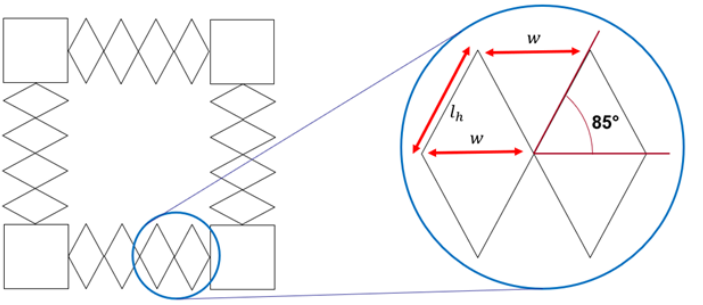
Figure 10. The initial configuration of the scissor-hinge